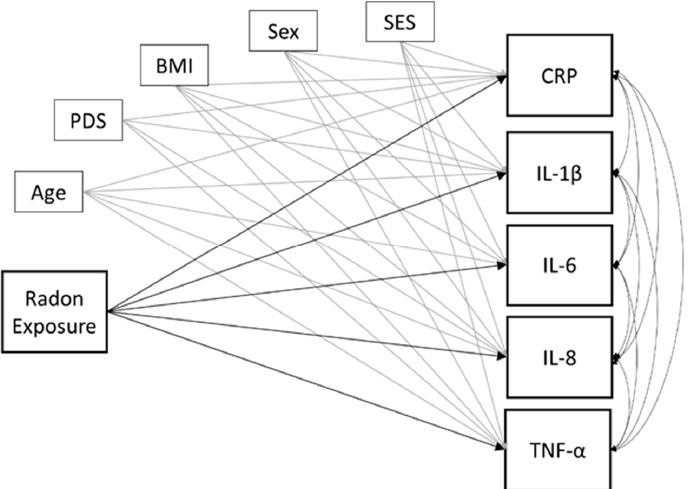
Figure 1. Conceptual model. Radon exposure is modeled as a predictor of each of the inflammatory markers of interest. Age, sex, SES, pubertal development, and BMI serve as control variables on all inflammatory markers. Single-headed arrows indicate directional, predictive relationships. Double- headed curved arrows show correlations. For clarity, control associations are shown in gray, and predictive relationships of interest are shown in black. Sex was dummy coded as 0 = “male”, 1 = “female”. “BMI” = body mass index; “CRP” = c-reactive protein; “IL” = interleukin; “PDS” = pubertal development stage; “SES” = socioeconomic status; “TNF- α ” = tumor necrosis factor alpha.